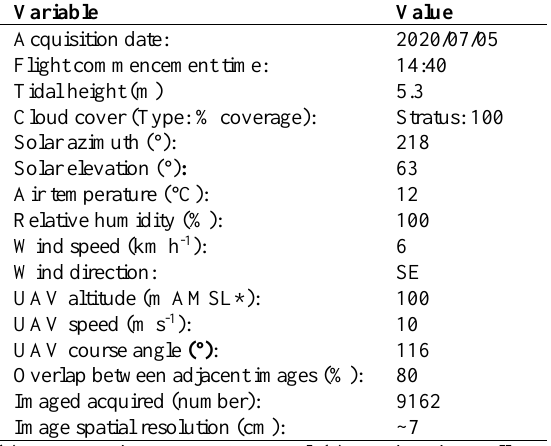
Table 2. Characteristics of the UAV imagery used and related environmental conditions during acquisition.